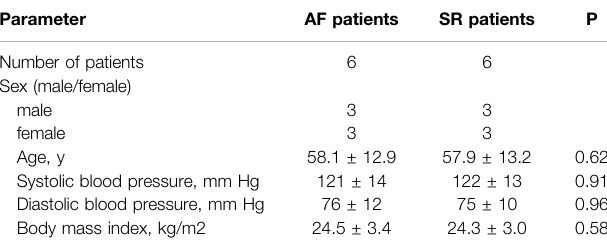
TABLE 1 | Main characteristics of 12 patients with rheumatic heart disease with mitral valve replacement combined with AF or SR.